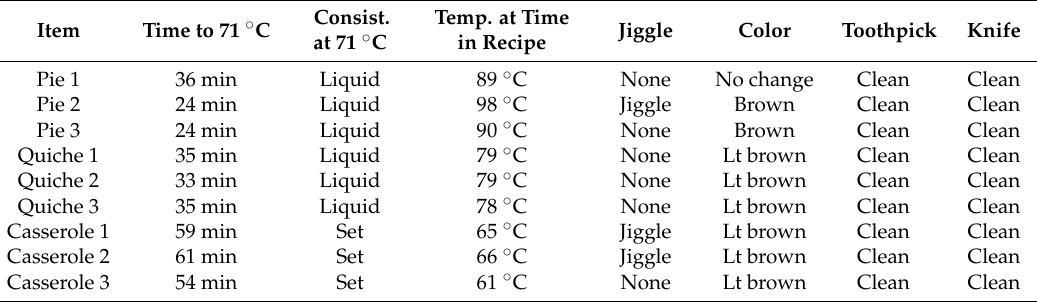
Table 2. Temperature and subjective measurements of the egg dishes during and after the cooking